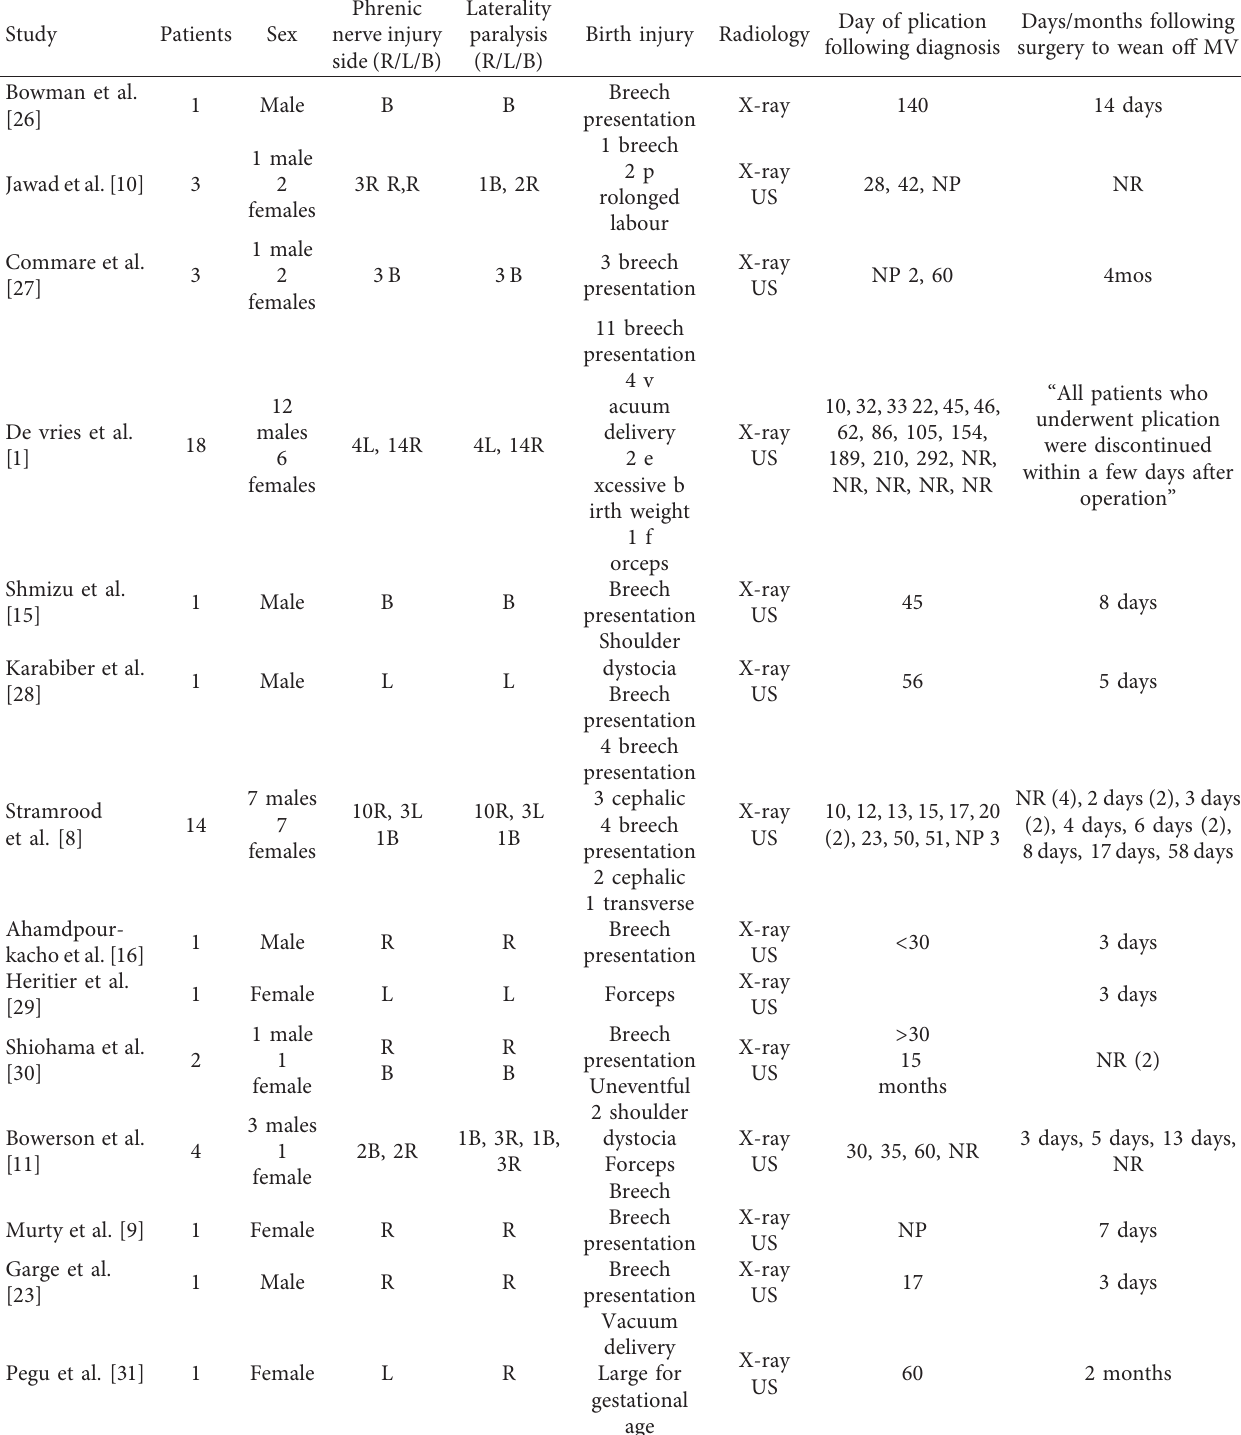
surgery to wean off MV